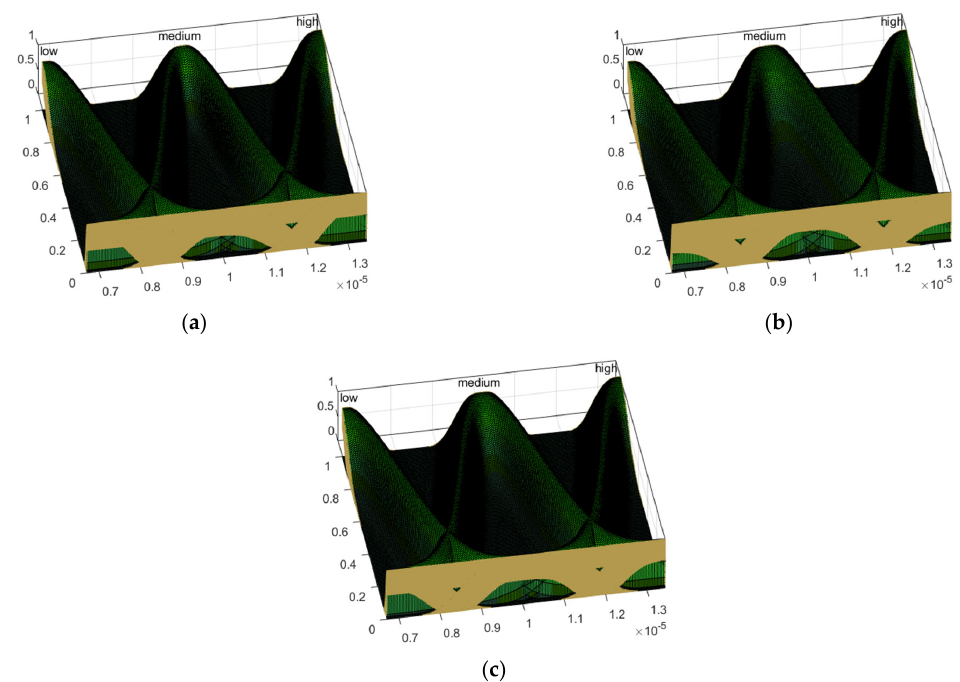
Figure 22. Best future prediction (France).